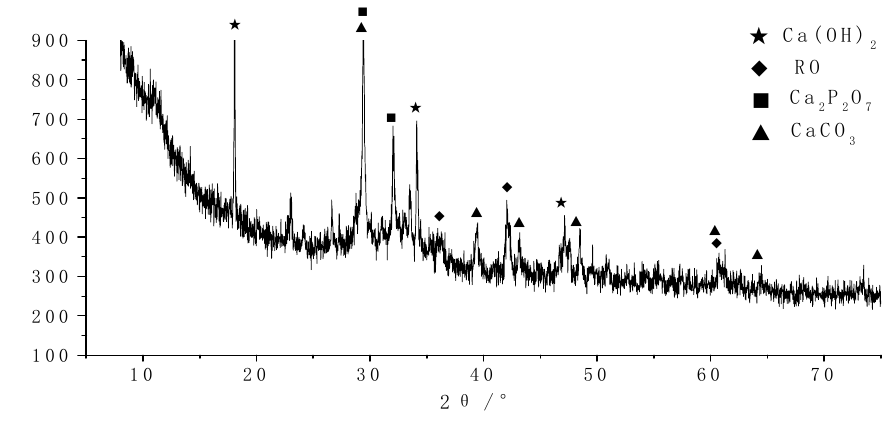
Figure 5. XRD diagram of 28 days of curing samples.